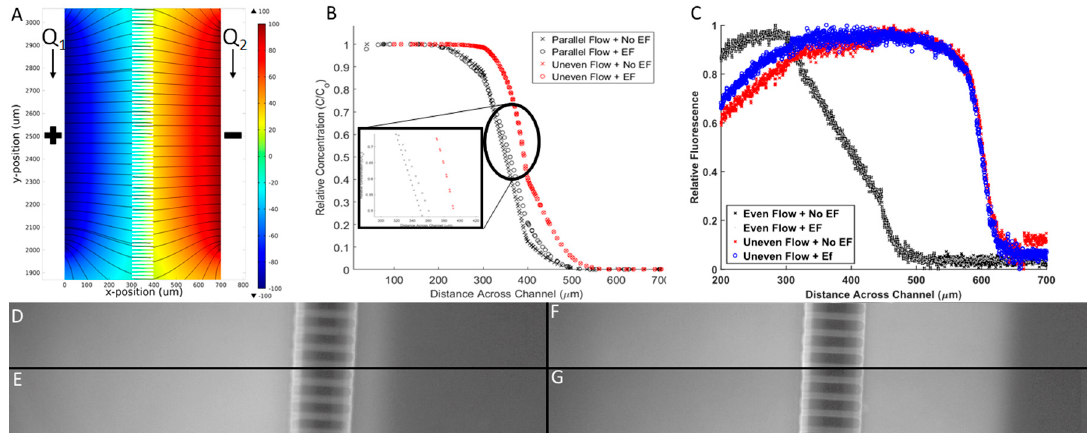
Figure 5. Electrical and chemical microenvironment of Gal-MµS. ( A ) Computationally-derived profiles of electric fields within the Gal-MµS using electric field strength = 100 mV/mm. ( B ) Computationally-derived, steady-state concentration profiles of a model molecule (10 kD dextran) using 4 combinatory fields: even flow (Q 1 = Q 2 ), with and without an applied electric field (100 mV/mm), and uneven flow (Q 1 > Q 2 ), with and without an applied electric field (100 mV/mm). ( C ) Experimental measurement of molecular transport within the device using the 4 combinatory fields. Note axes have been modified to better illustrate position of experimental data. Fluorescent images for the 4 stimulation conditions: ( D ) Even flow with no applied electric fields (EF), ( E ) even flow with EF, ( F ) uneven flow with no EF, and ( G ) uneven flow with EF. All images were taken within the region between the two electrodes.